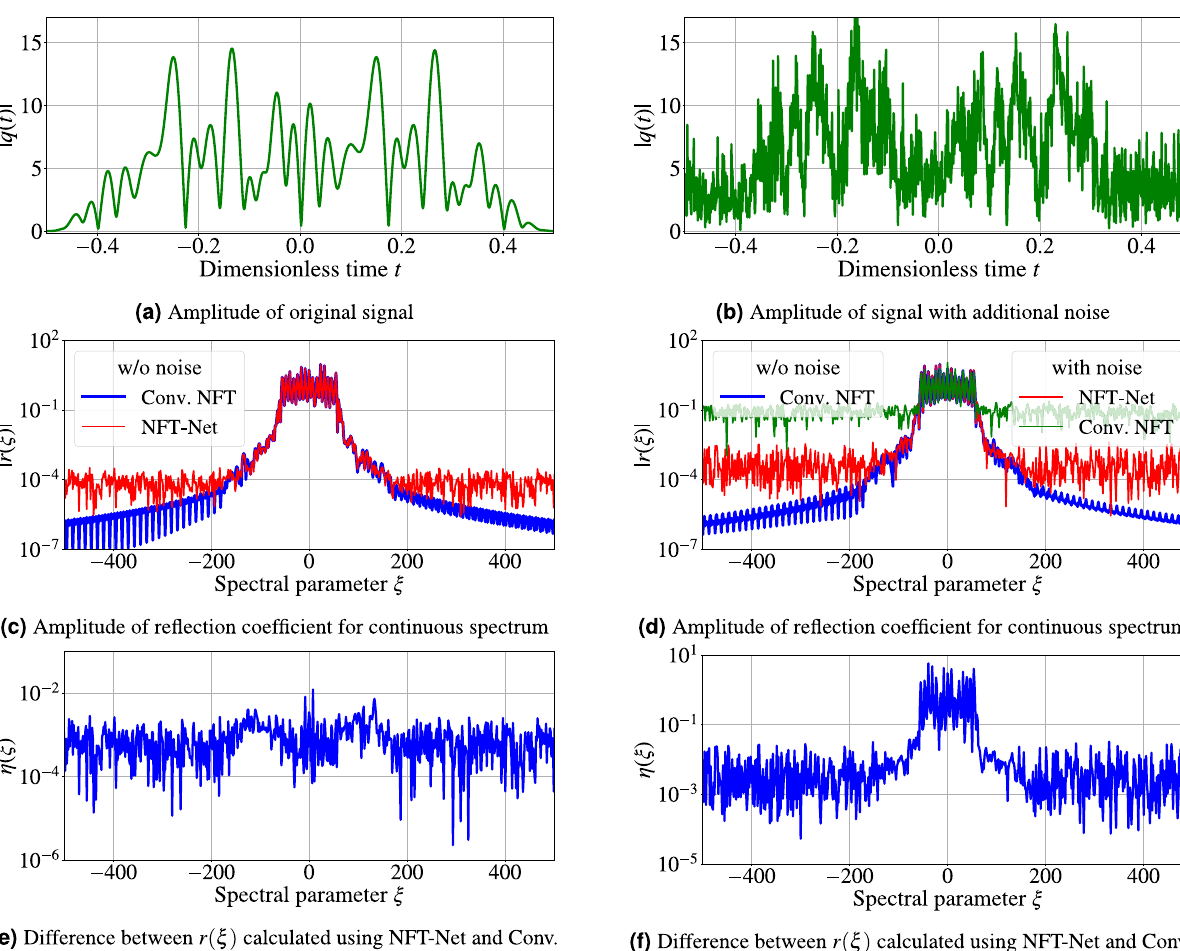
Figure 4. Panel (a) shows an exemplary amplitude of a original complex WDM signal q ( t ) versus time. Below (panel (c) ) is the amplitude for calculated scattering coefficient r (ξ) associated with the signal from the pane above. The blue line corresponds to the data obtained using the conventional NFT method, the red line corresponds to the NFT-Net result. The difference between the scattering coefficients for signal example calculated by these methods is shown in panel (e) . Pane (b) : the same plot for complex signal q ( t ) with the addition of Gaussian noise. The SNR value used is 5 dB. Plot (d) shows the result of calculating the continuous spectrum for the noisy signal using the FNFT method (green line) and using the NFT-Net trained at the same noise level (SNR = 5 dB, red line) and original spectrum (for noiseless case, blue line). For NFT-Net trained with noise, pane (f) below shows the difference between the predicted scattering data for the example of noisy signal and the reflection coefficient calculated by conventional NFT for that signal without method, i.e. it successfully purifies our signal from noise, the respective cell is not highlighted (white). Whence, the white area size in each table demonstrates how well the NFT-Net retrieves the nonlinear spectrum for noise- corrupted signals. Table 1 shows the error values for the restoration of r (ξ) coefficient (10) of a noiseless and noisy-perturbed signals (2), by the NFT-Net architecture given in Fig. 3. The first row in the table corresponds to the noiseless case. It is always marked with bold, which means that the NN cannot provide any better results than the benchmark ones rendered by the conventional fast NFT method used to generate the training data. However, the values of the error for noise-corrupted signals reveal interesting tendencies. It follows from the table that for the low training noise level (up to 10 dB, columns three through nine), the NFT-Net error is typically lowest for the noiseless validation dataset (second row). Thus, the addition of low noise in the train- ing dataset only degrades the NFT-Net restoration capability, even though this decrease is not significant. This NFT-Net feature can be deemed as the NN’s being “confused” by the weak noise in its training in the nonlinear transformation identification. For the most interesting case of high noise, the network works best for samples where the SNR value is the same for the validation and training sets. In such cases, the relative error is about 8–12%, while the error for conventional NFT is at the level of 100–200%. Another fact is that with decreasing noise (rows from bottom to top) in the validation set, the error value remains at approximately the same level after the cell corresponding to the same training and validation noise values. These results confirm that the presented